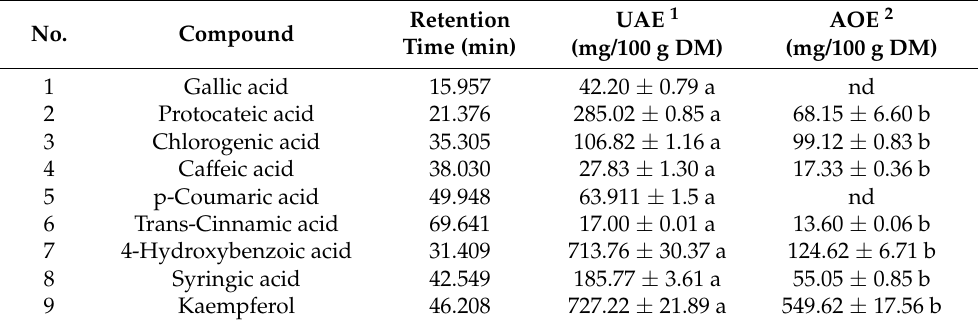
Table 7. Phenolic compounds profile from Psidium cattleianum leaf extracts using the optimal condi- tions of ultrasound-assisted extraction and conventional aqueous–organic extraction. Retention UAE 1 AOE 2 No. Compound Time (min) (mg/100 g DM) (mg/100 g DM) 1 Gallic acid 15.957 42.20 ± 0.79 a nd 2 Protocateic acid 21.376 285.02 ± 0.85 a 68.15 ± 6.60 b 3 Chlorogenic acid 35.305 106.82 ± 1.16 a 99.12 ± 0.83 b 4 Caffeic acid 38.030 27.83 ± 1.30 a 17.33 ± 0.36 b 5 p-Coumaric acid 49.948 63.911 ± 1.5 a nd 6 Trans-Cinnamic acid 69.641 17.00 ± 0.01 a 13.60 ± 0.06 b 7 4-Hydroxybenzoic acid 31.409 713.76 ± 30.37 a 124.62 ± 6.71 b 8 Syringic acid 42.549 185.77 ± 3.61 a 55.05 ± 0.85 b 9 Kaempferol 46.208 727.22 ± 21.89 a 549.62 ± 17.56